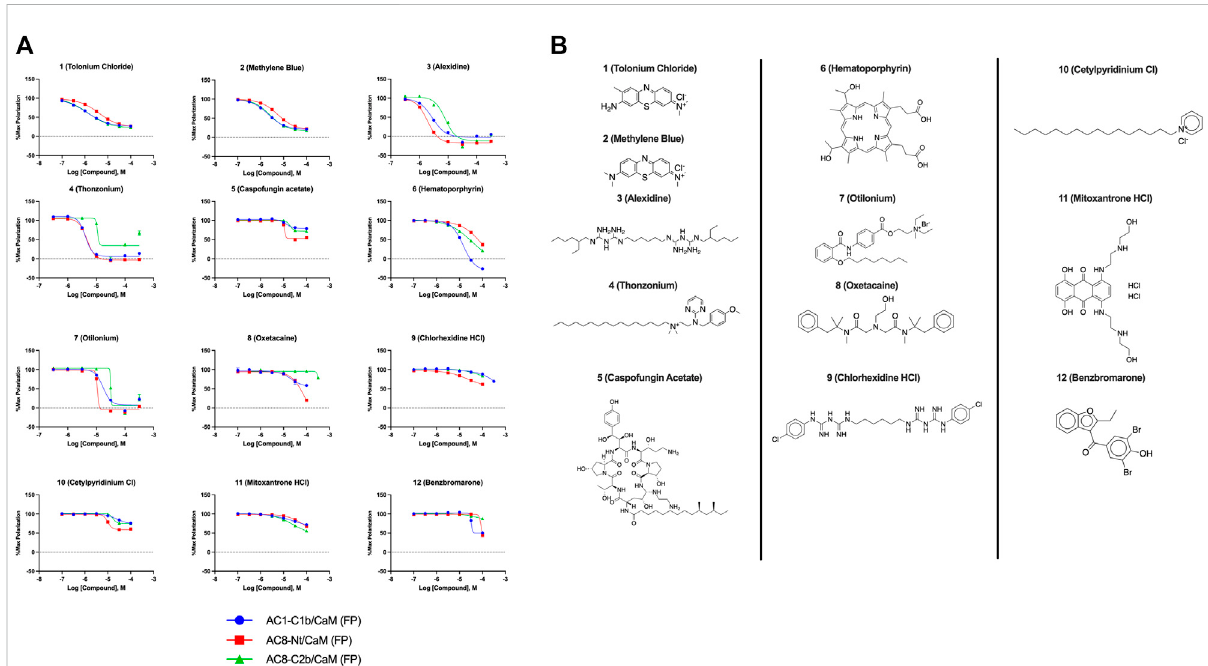
FIGURE 3 Concentration response curves (A) and structures (B) for FDA-approved and MMSP library hits. Each hit was used to generate CRCs in the AC1- C1b/CaM (blue circles), AC8-Nt/CaM (red squares), and AC8-C2b/CaM (green triangles)FPassays. (B) The structures for eachhitare shown with the hit number and the given compound name. Data is normalized to vehicle (100% maximum polarization) and 100 μ M CDZ (0% polarization). All data represents n = 3 experiments